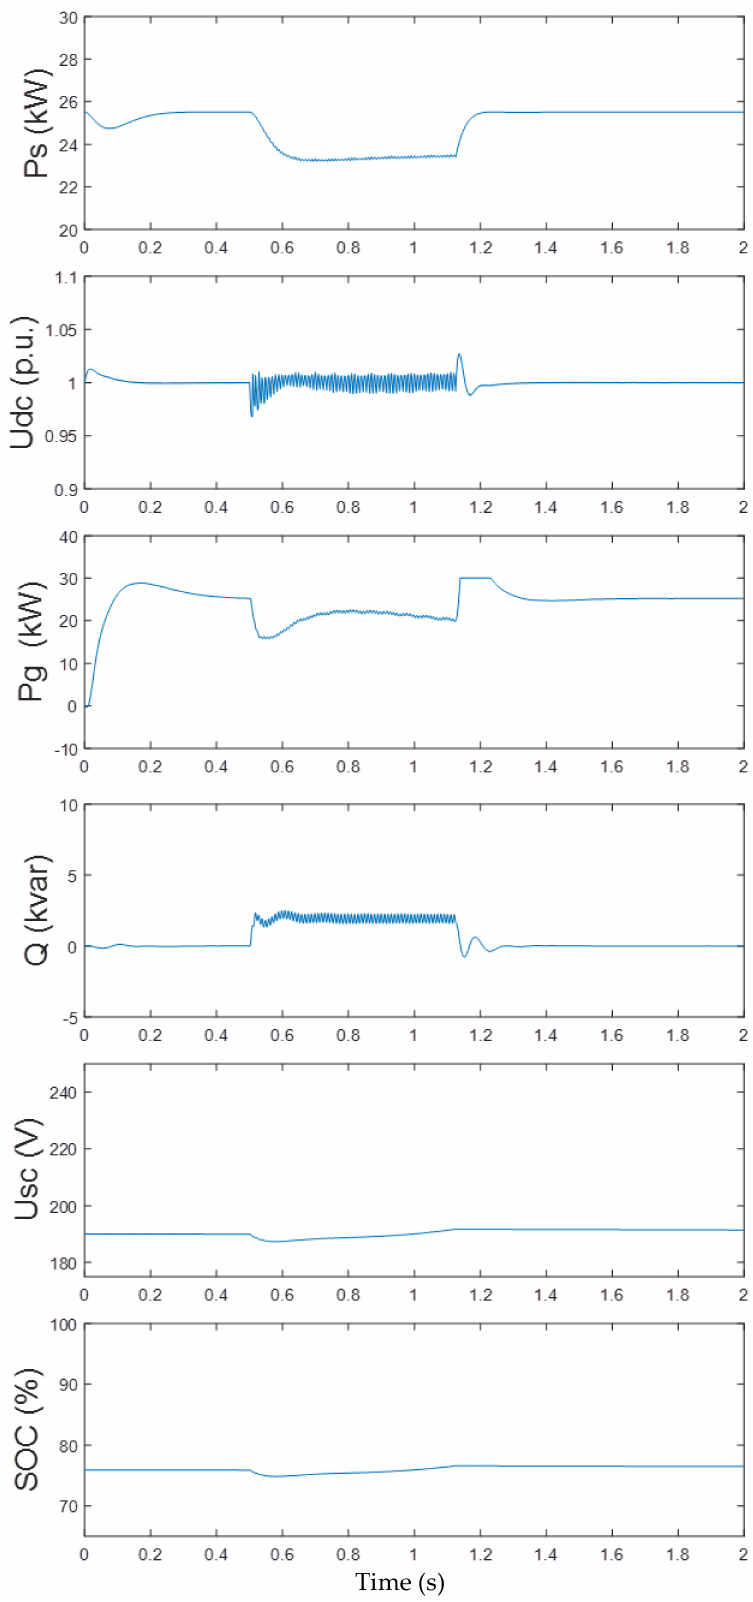
Figure 14. The simulation results of the overspeed-while-storing control under a single line-to-ground